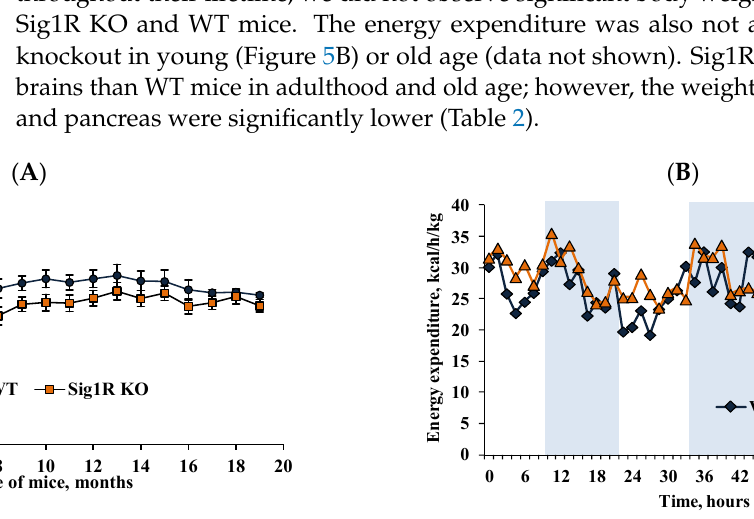
Figure 5. Weight and energy expenditure in Sig1R KO and WT mice. ( A ) Body weight gain throughout their lifetime. ( B ) The energy expenditure profile was measured within 72 h for 2-month-old mice (shaded area indicates dark hours, 08:00–20:00). Data are shown as the mean ± SEM ( n = 5–11 mice/group). Table 2. Organ weight versus body weight coefficients.